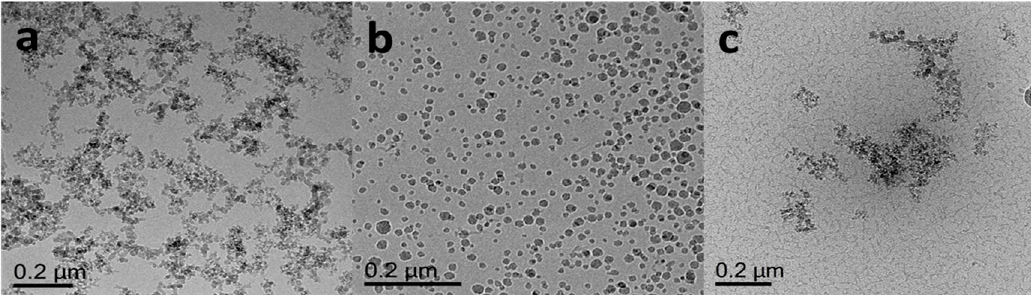
Figure 1. Cryo-transmission electron microscope (TEM) image of nanoparticles: ( a ) fumed hydrophilic silica nanoparticles (FNP); ( b ) amide-functionalized colloidal silica nanoparticles (ANP); ( c ) surface-modified FNP with zwitterionic polymer (FNP-MD).